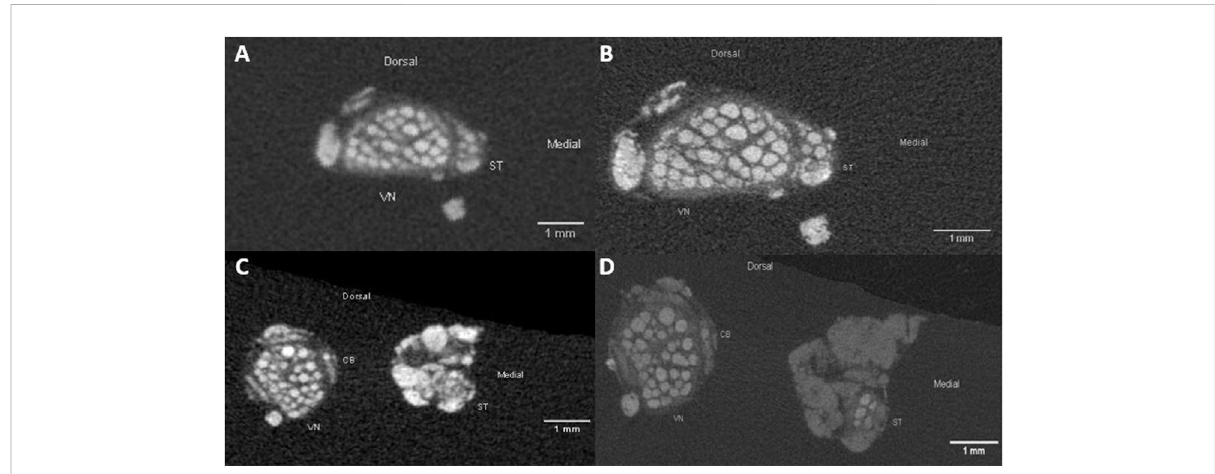
FIGURE 3 ComparisonofthepigVNandSTanatomyincervicalnervespecimeninlow-resolution (A) ;20 µmisotropicresolutionandhigh-resolution (B) ; 8.9 µm isotropic resolution). Differences are visible in the sharper representation of structures of interest, such as fascicles and epineurium. The silk sutures fi xedontheventralsideofthenervesarerepresentedbythebrightspotsonthebottomsiteoftheimages. (C,D) :Exampleimagesofacaudal nerve specimen showing the anatomical comparison of the VN, ST and CB at level of the cardiac branching point in low-resolution (panel C; 20 µm isotropic resolution) and high-resolution (panel D; 8.9 µm isotropic resolution). VN, cervical vagus nerve; ST, sympathetic trunk; CB, cardiac branch.